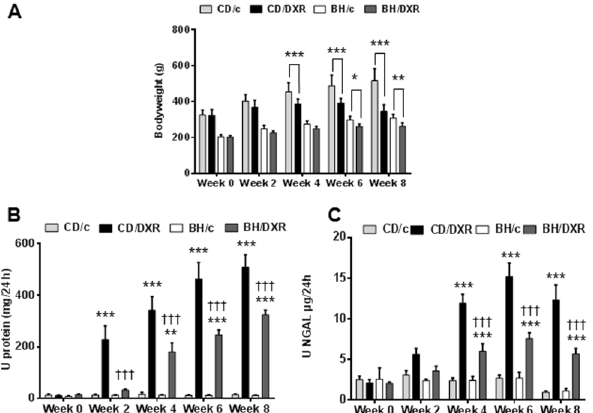
Fig 2. Body weight changes (A) proteinuria (B) and urinary NGAL excretion (C). CD: CD rats, BH: BH rats. c: saline-injected, DXR: Doxorubicin-injected rats (5 mg/kg). * : p < 0.05 vs. strain-identical, negative control group, † : p < 0.05 vs. CD/DXR, positive control